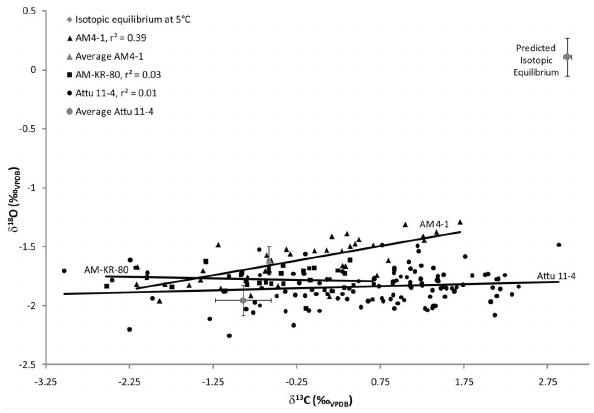
Figure 3. 609 Fig. 3. The δ 18 O values plotted against the δ 13 C values for the skeleton of three specimens of coralline algae with regression lines. Larger grey symbols represent the average δ 13 C (for 1992–1993) and δ 18 O (for 1990, 1993, and 1995) for Attu11-4 and AM4-1. Predicted isotopic equilibrium for inorganic calcite is plotted (grey diamond) based on the δ 13 C and δ 18 O values for seawater from 1992–1993 and 1990, 1993, and 1995, respectively, and equations from Romanek et al. (1992) and Kim and O’Neil (1997), respec- tively. In order to account for the fact that coralline algae are High Mg-calcite, the equation for δ 18 O value incorporated the ad- dition of 0.17‰ for each mol%Mg according to Jim´enez-L´opez et al. (2004). The equation for δ 13 C value incorporated the addi- tion of 0.024‰ for each mol%Mg according to Jim´enez-L´opez et al. (2006). The value of 9.9mol%Mg used was the median value from the range given in Hetzinger et al. (2009). Error bars indi- cate one standard error around the average. Error bars not visible are smaller than symbol. Predicted equilibrium is not plotted for AM-KR-80 as this sample was collected prior to the early